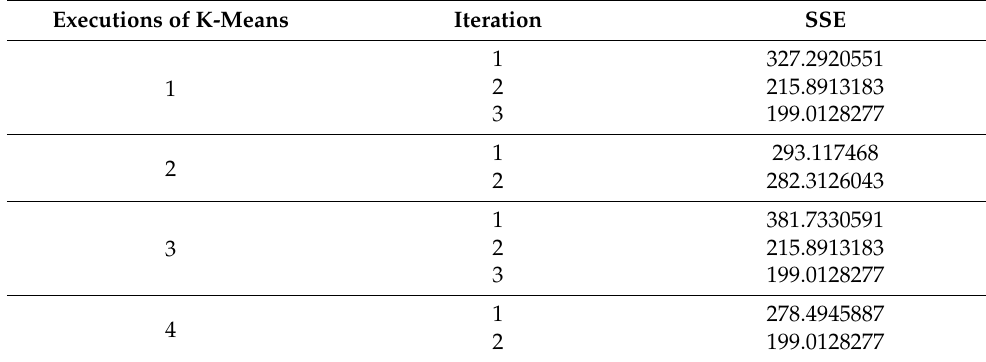
Table 6. The variation of SSE.